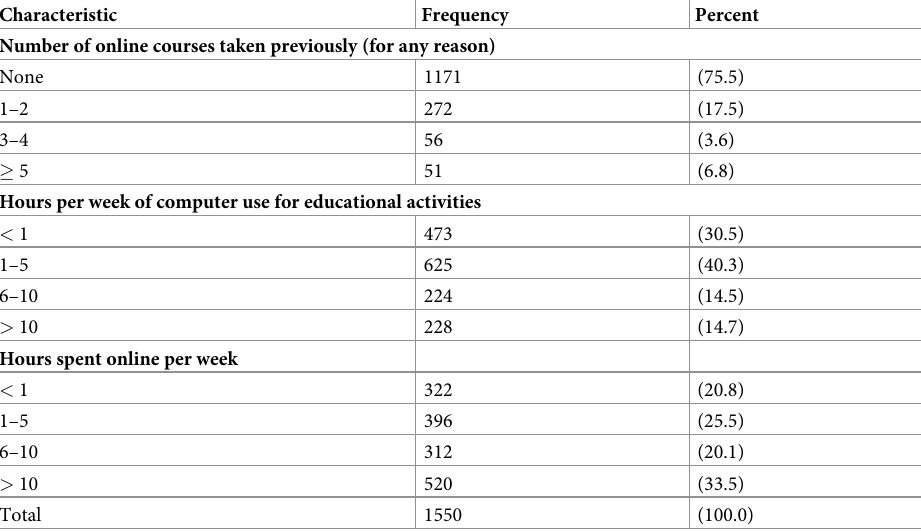
Table 2. Online activities by students ( n = 1550).